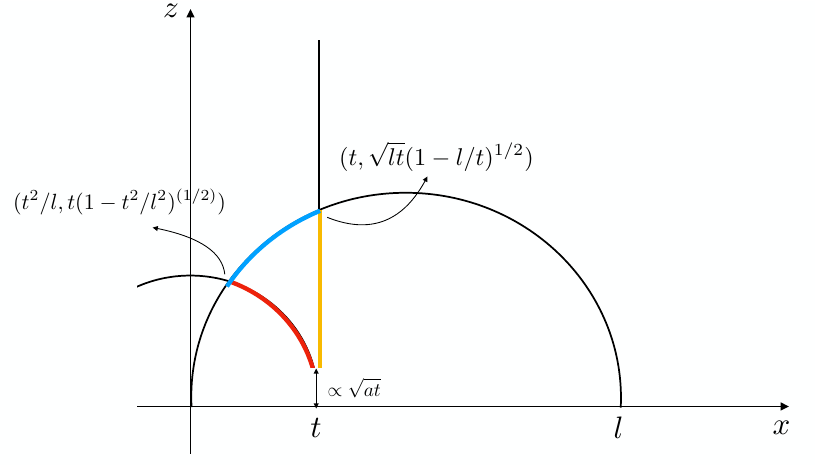
Figure 49 . Numerical evidence for that z coordinate of the tip is proportional to √ at at t (Left figure) Vertical axis: z 2 , horizontal axis: t . Green line: a = 1, yellow line: a = 1 / 2, blue line: a = 1 / 4. We can see that the curve becomes linear at late time. (Right figure) Vertical axis: z 2 ratio for different a , horizontal axis: t . Blue line: ( z 2 at a = 1 / 2)/ ( z 2 at a = 1), yellow line: ( z 2 at a = 1 / 4)/ ( z 2 at a = 1). We can see that at late time they goes to 1/2 and 1/4 respectively.